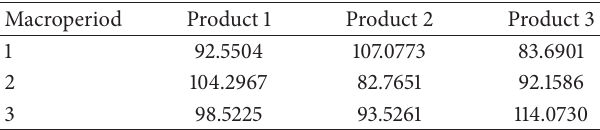
Table 3: Employed realizations of the random product